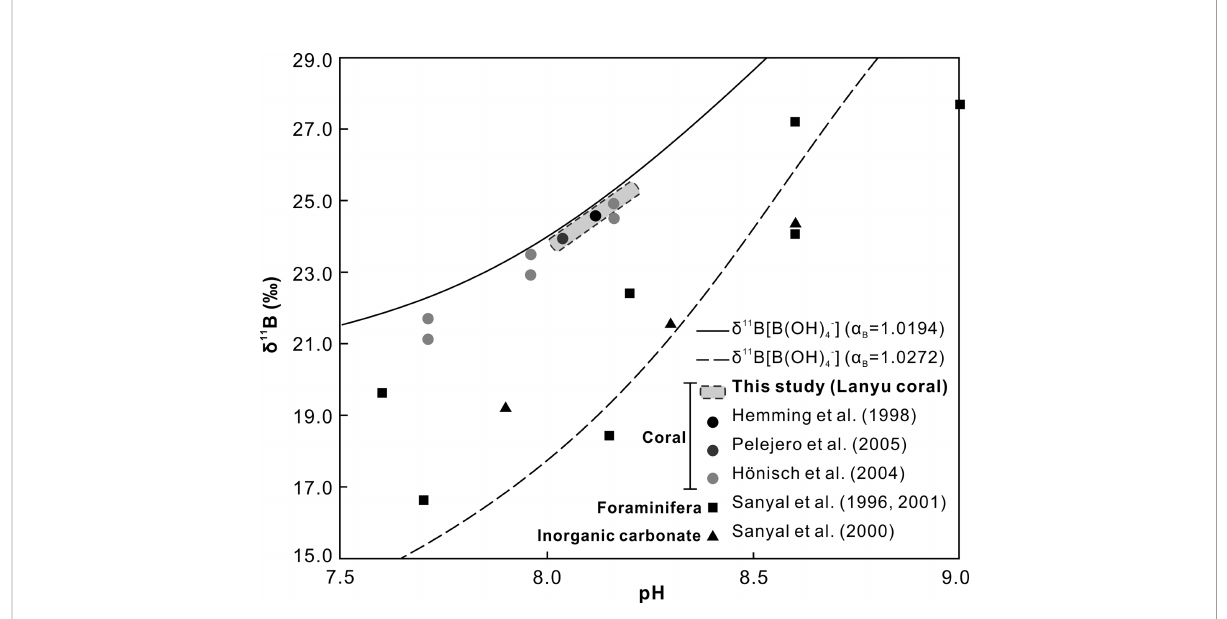
FIGURE 6 pH dependence of the boron isotopic composition of B(OH) 4 − based on theoretical a B = 1.0194 (blue) (Kakihana et al., 1977) and empirical d 11 B data of scleractinian corals (square), foraminifers (circle), and inorganic a B = 1.0272 ± 0.0006 (red) (Klochko et al., 2006) at 25°C. The calcite precipitation (triangle) are also plotted. Note that most coralline specimens fi t better with the Kakihana ’ s curve, but foraminifers and inorganic calcite precipitation agree more with the Klochko ’